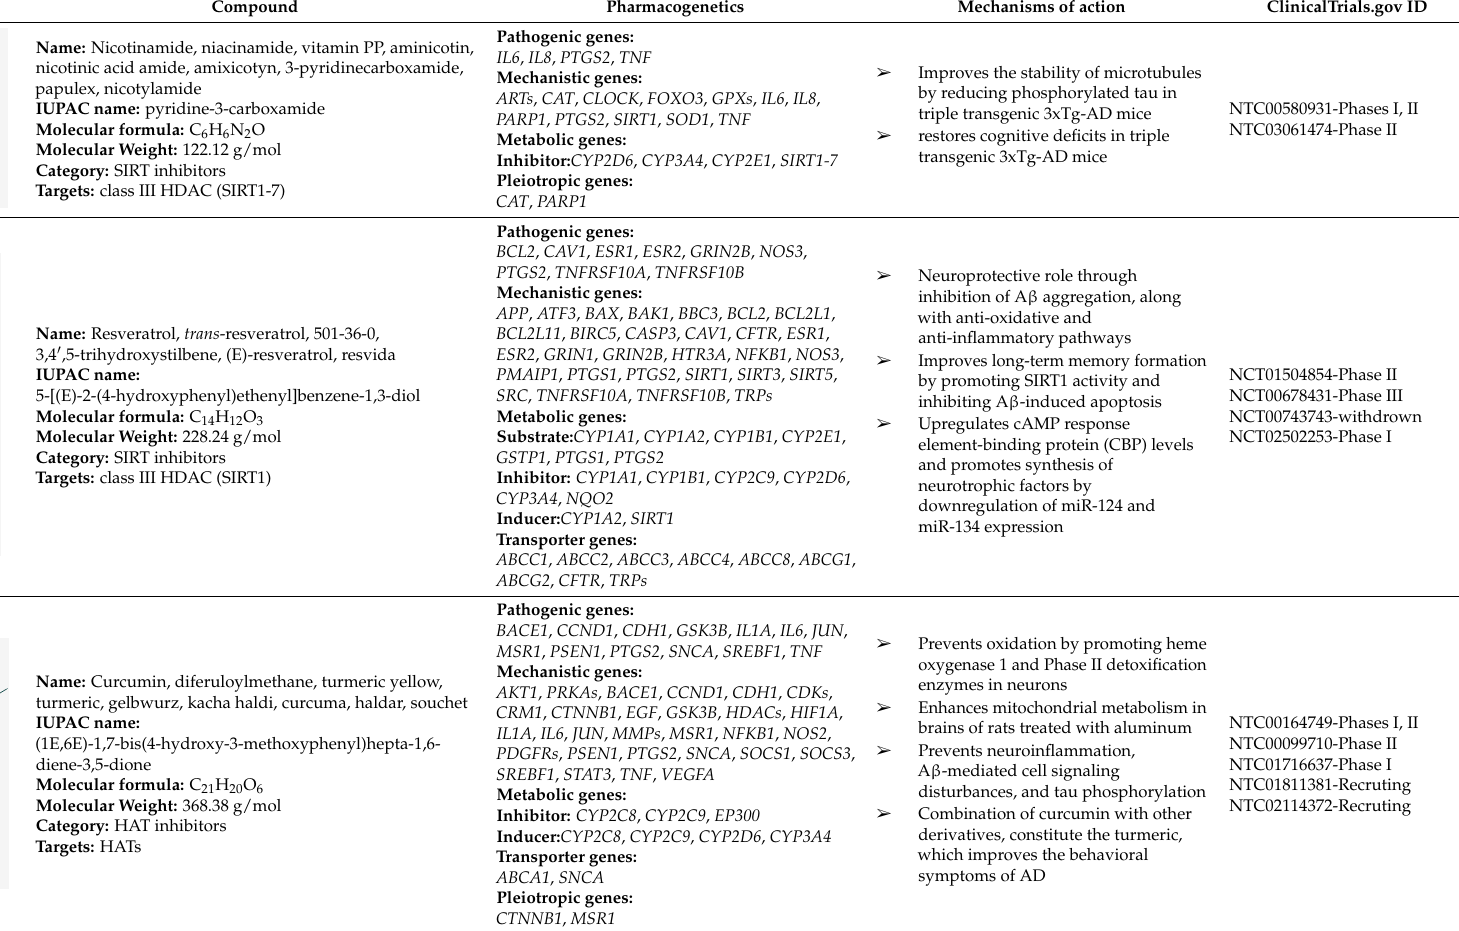
(cid:226) Prevents oxidation by promoting heme oxygenase 1 and Phase II detoxification enzymes in neurons (cid:226) Enhances mitochondrial metabolism in brains of rats treated with aluminum (cid:226) Prevents neuroinflammation, A β -mediated cell signaling disturbances, and tau phosphorylation (cid:226) Combination of curcumin with other derivatives, constitute the turmeric, which improves the behavioral symptoms of AD